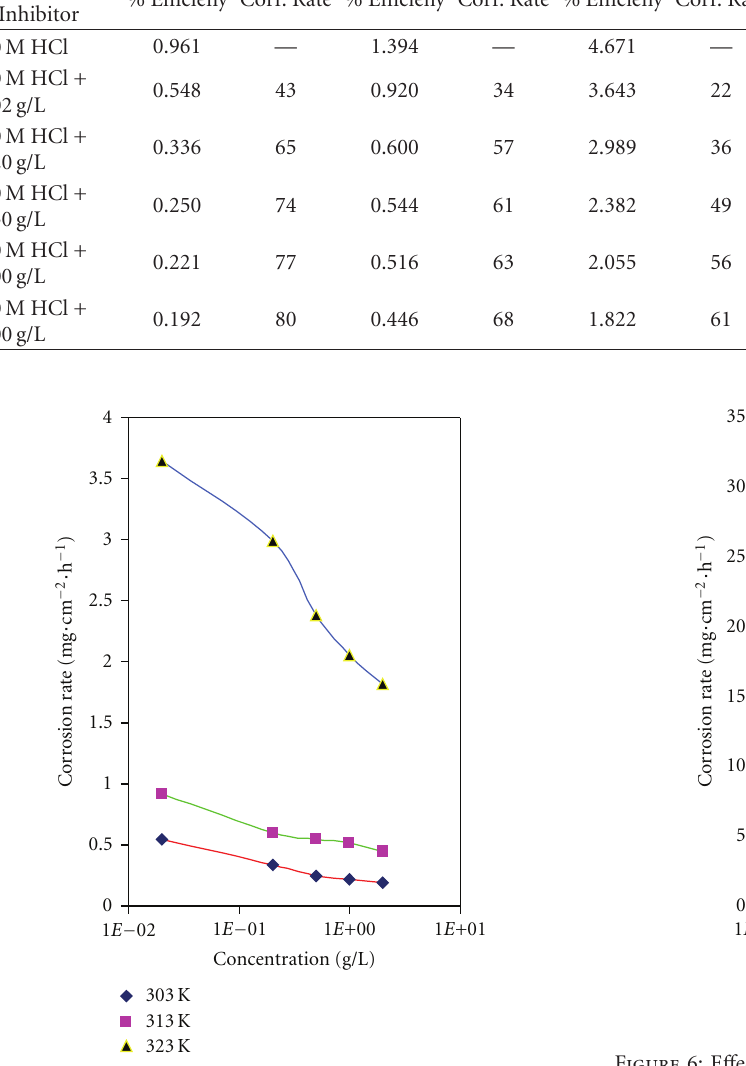
Figure 5: E ff ect of concentration of the aqueous extract of Neem leaves on the corrosion rate (mg · cm − 2 · h − 1 ) of carbon steel in 1.0 M HCl at various temperatures.